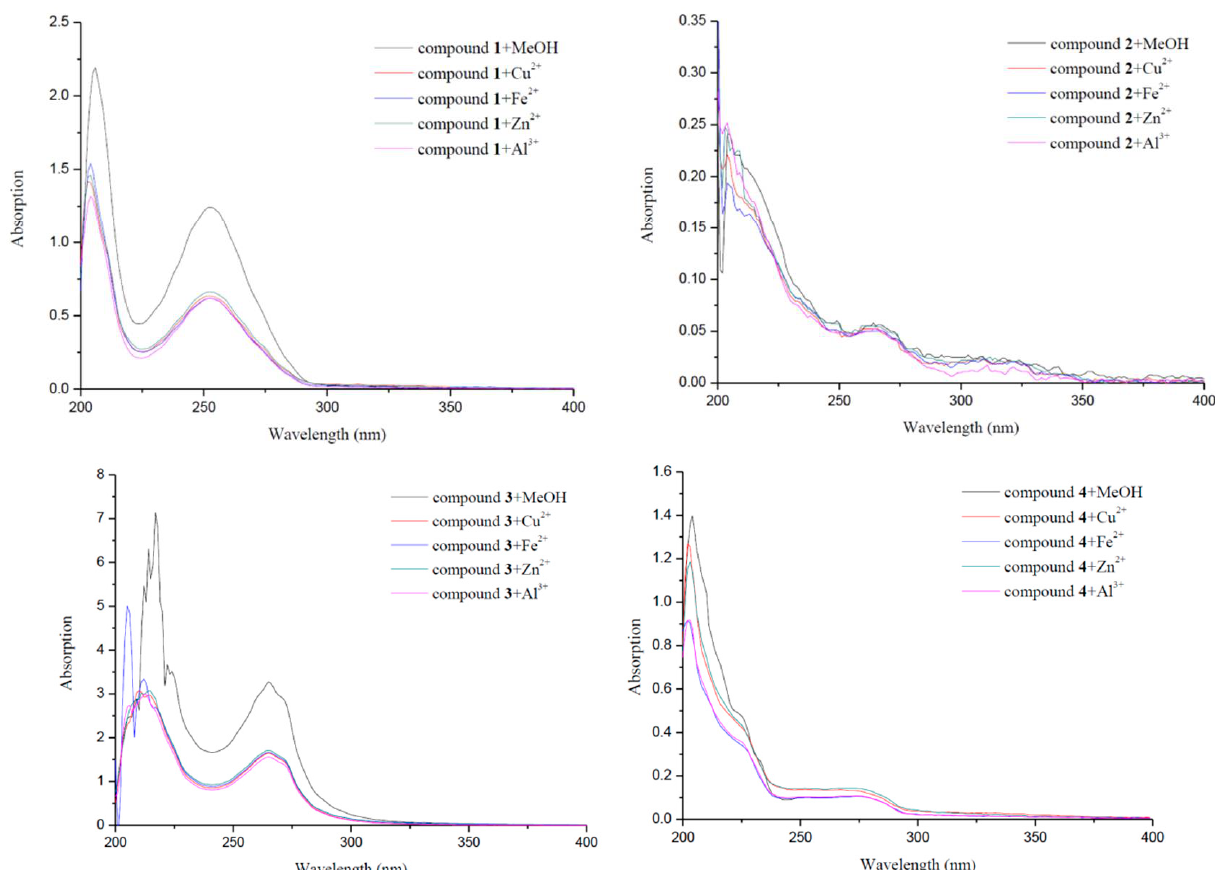
Figure 6. UV spectra of compounds 1 – 4 alone or in the presence of CuCl 2 , FeCl 2 , ZnCl 2 or AlCl 3 .